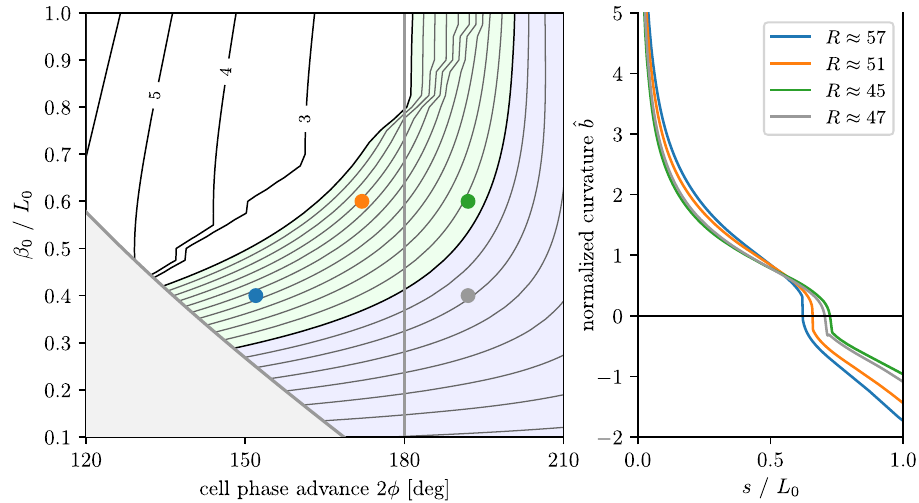
FIG. 9. TME emittance ratio F and example curvatures for optimized LGB cells without sign constraints on b ð s Þ (see Fig. 6 for